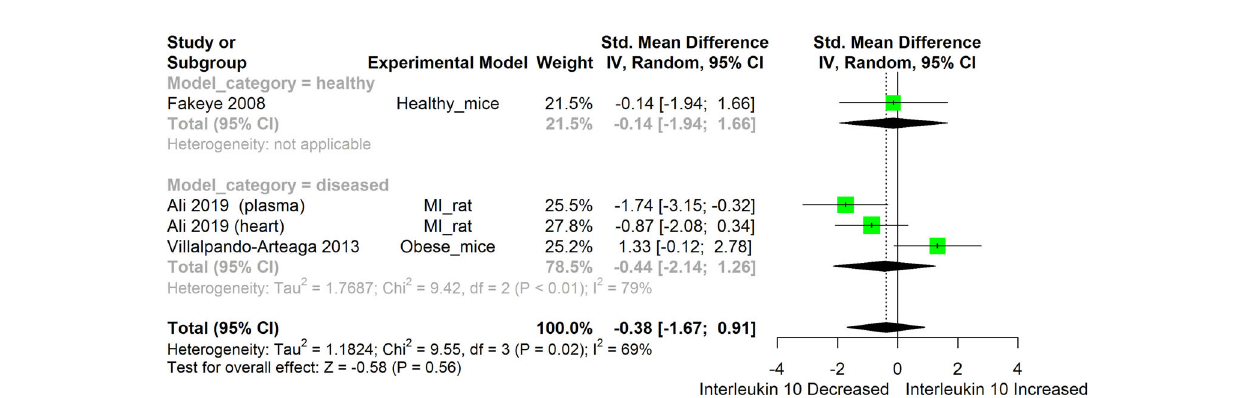
FIGURE 10 | Meta-analysis and forest plot of the effect of HS administration on IL-10. The meta-analysis was sub-grouped by health status (i.e diseased or healthy state). The standardized mean difference (SMD) which is an estimate of the effect size, is presented as a square on the forest plot, for each study and as a diamond for the pooled estimate of each subgroup or overall studies. The overall pooled SMD for all included studies is shown in the bottom section of the forest plot. SMD data points that are lower than zero signify that treatments with HS lowered the level of the biomarker while those greater than zero signify that HS treatment caused an increase in the levels of the biomarker. The statistical signi fi cance of the pooled estimate is indicated by the Z test of signi fi cance. MI, Myocardiac